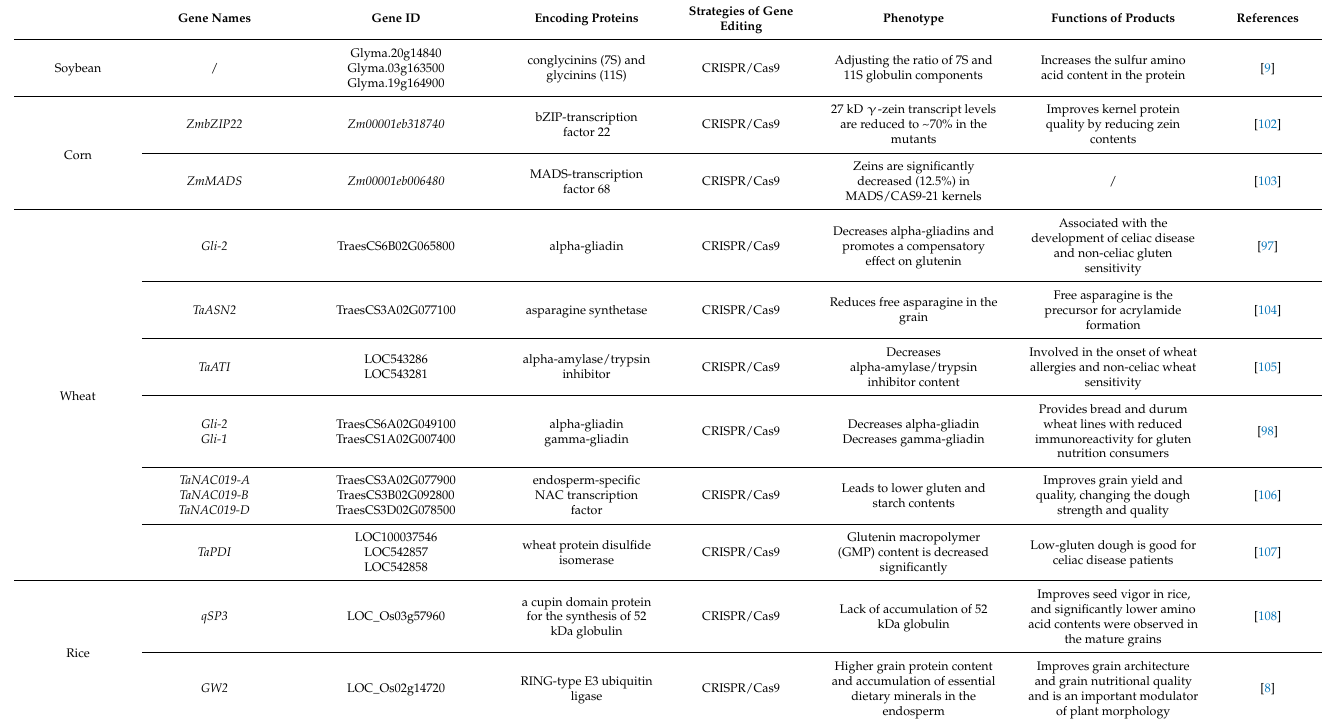
Table 3. Gene resources for protein improvement in rice, wheat, corn and